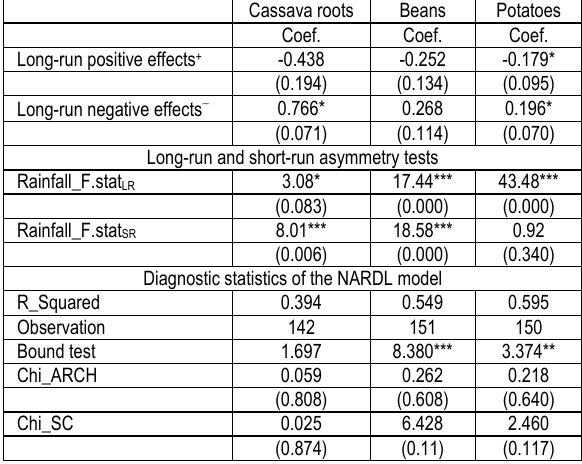
Table 4. Asymmetric statistics on rainfall effects of food